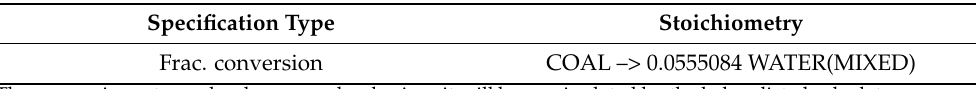
Table A3. Pseudo-reactions in RSTOIC unit operations for NC component handling regarding separation ( SEP 1) and drying ( DRYER ).